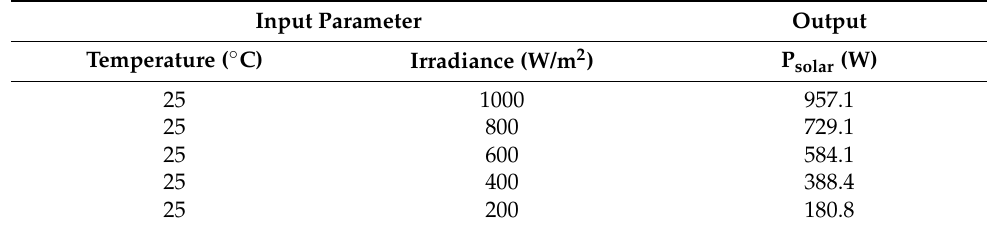
Table 2. P solar simulation results (OSSC size of 9.75 m 2 ).